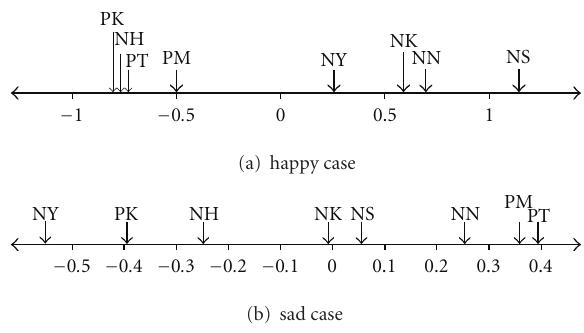
Figure 5: Psychological scales constructed using Sche ff ´e’s method of paired comparison and impression levels of the eight best lightings designed by the eight subjects. PM, PT, and PK are three schizophrenics, and NS, NN, NK, NY, and NH are five mentally healthy